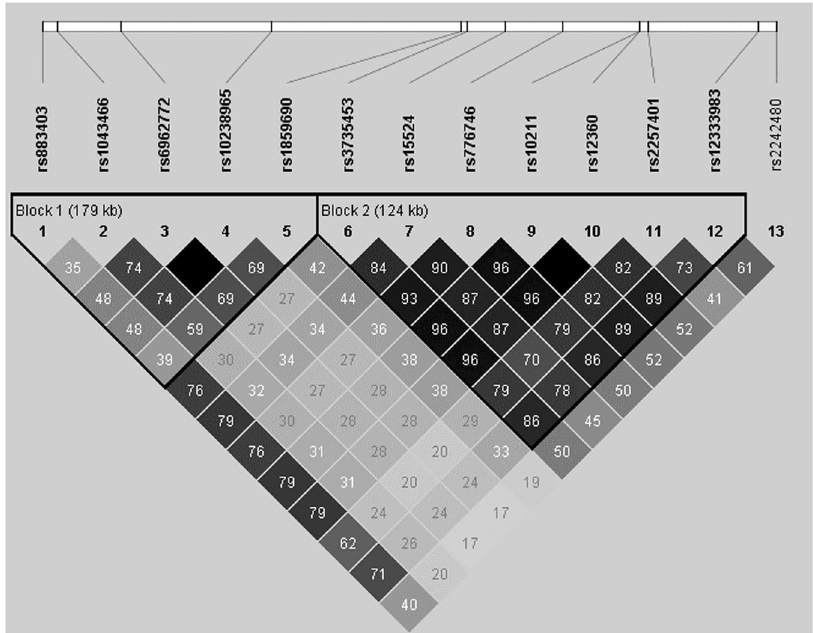
Figure 4. Haplotype plots of variants on chromosome 7 commonly associated with dose-adjusted tacrolimus trough concentrations from day 7 to 1 year after